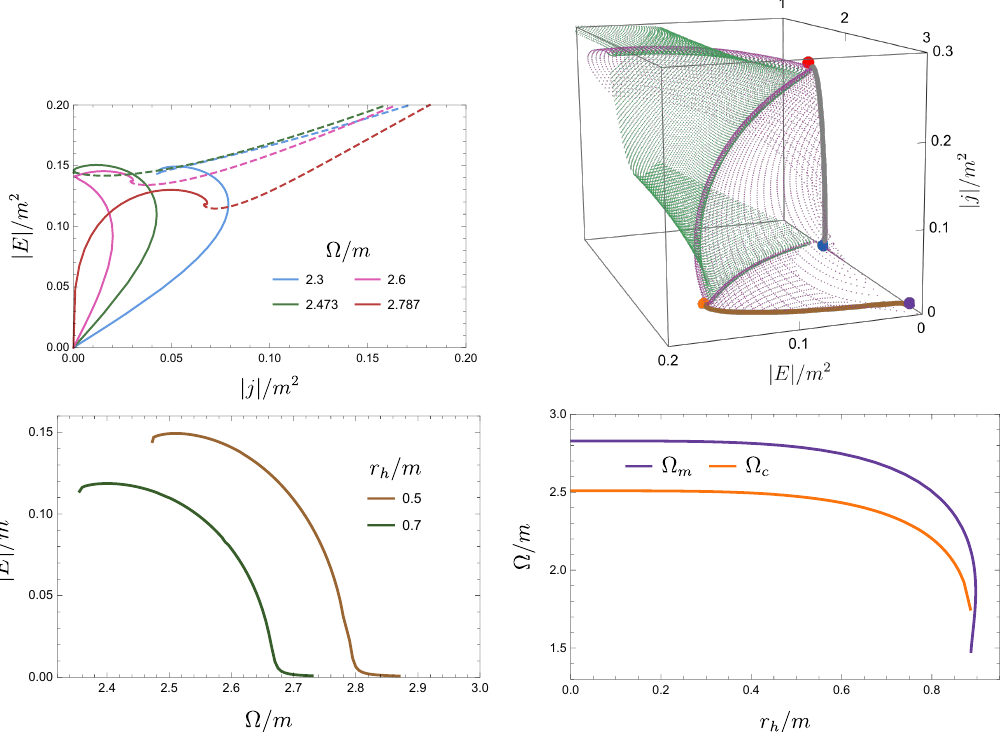
Figure 7 . Top : on the left, plots of | j | /m 2 vs. | E | /m 2 where we exchanged the axes to make apparent the striking similarity with the plots in figure 4. On the right, 3D plot where the range of Ω has been extended to cover the first vector meson Floquet condensate (grey curve at | E | = 0 ) as well as the first Floquet suppressed condensate (brown curve at | j | = 0 ). Bottom : the left plot shows view of the | j | = 0 plane of the upper plots. The suppressing effect of the temperature is apparent. The right plot is the downshift in Ω of the two extreme points (orange and violet) in the plot above this, as a function of r h /m